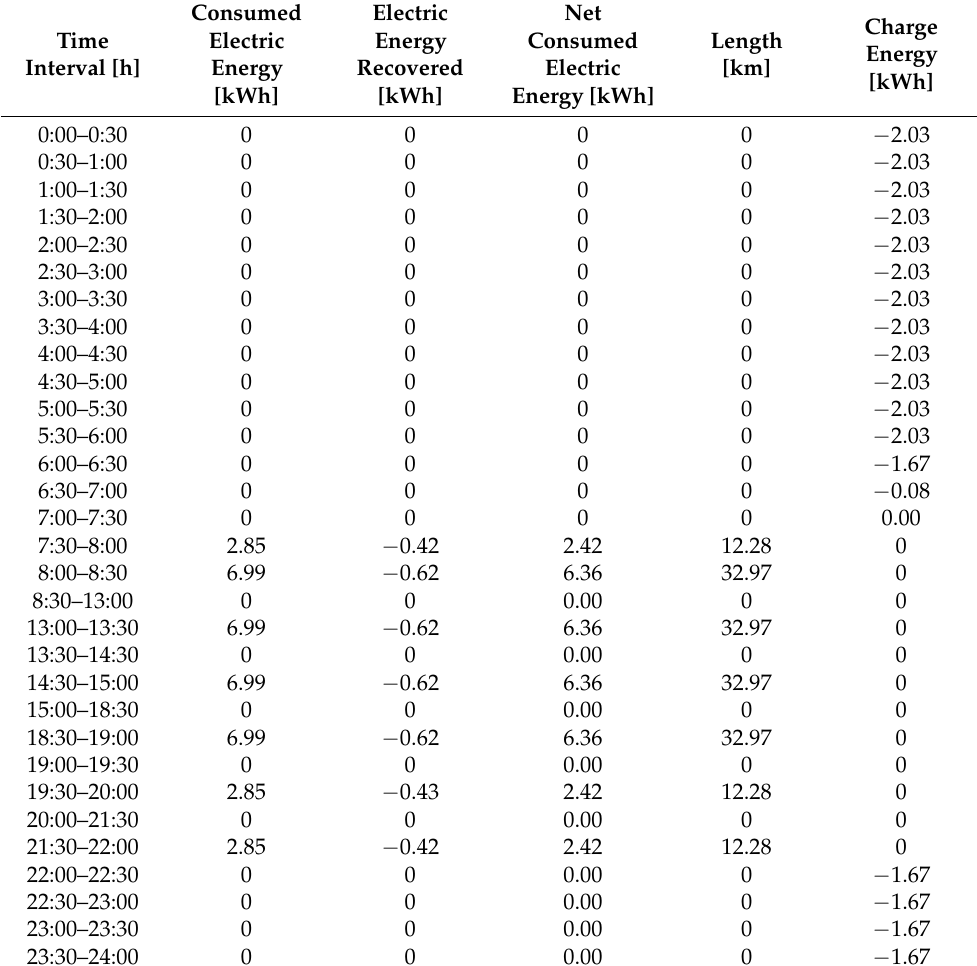
Table 12. Mobility pattern 2